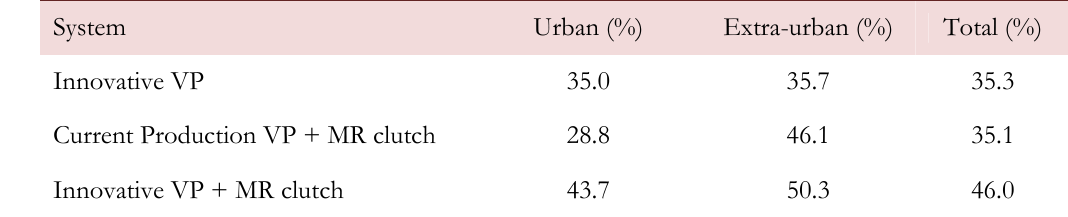
Table 4: Energy absorption during NEDC driving